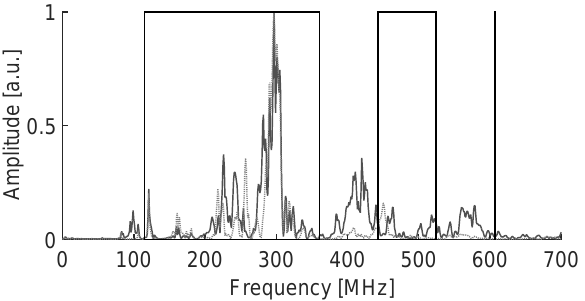
Figure 7. Average spectra of the pulses and the selected intervals that maximize the Mahalanobis distance. The solid line plot corresponds to cluster 1 and the dotted plot to cluster 2.